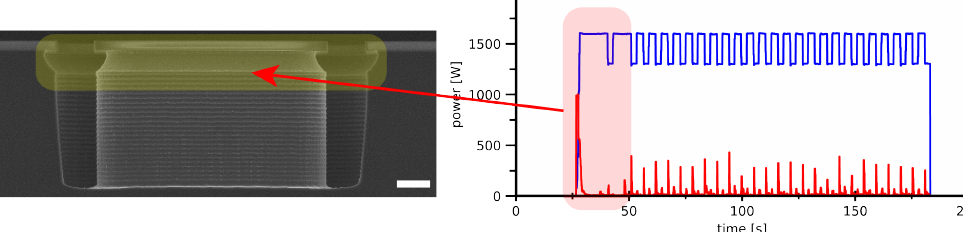
Figure 18. SEM images of test structures with their corresponding graphs displaying the inserted ICP power and power reflected during the process. Changing the pre-deposition step of the standard two- step Bosch-based recipe (Table 1) into the entrance etch sequence (Table 3) resulted in an unmatched ICP network, which influenced the results of the entrance etch to a great extent. Both scale bars are 3µm. Colours represent: IPC power and reflected